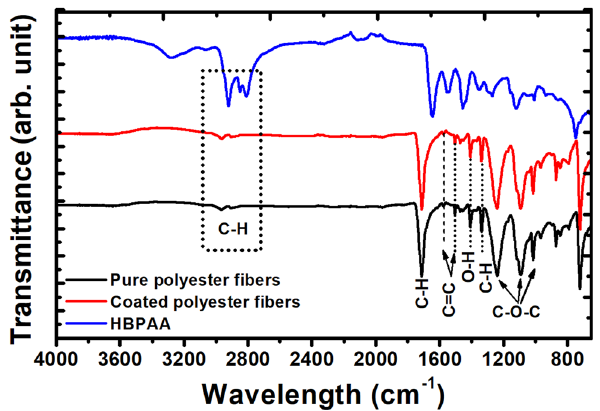
Figure 4: FTIR spectra of ( black ) pure and ( red ) treated polyester fi bers and ( blue )